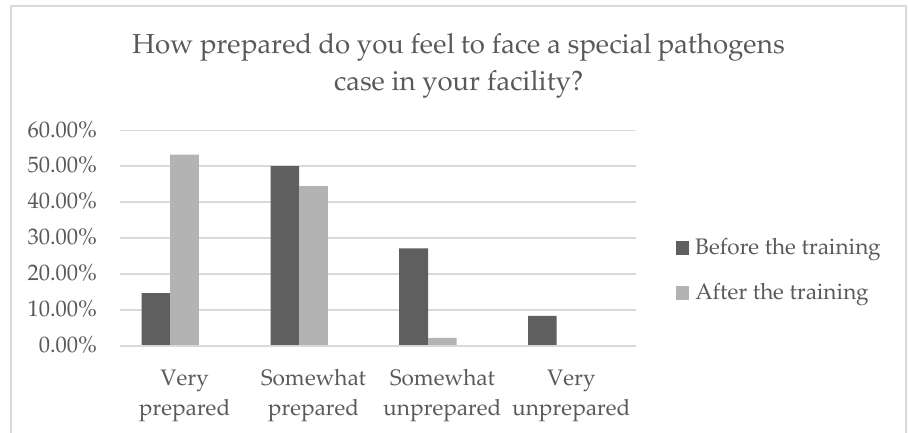
Figure 4. Of the 45–48 participants, most reported feeling somewhat prepared or somewhat unprepared before the training, with some feeling very prepared or unprepared. After the training, almost every participant reported feeling prepared, with the majority feeling very prepared.